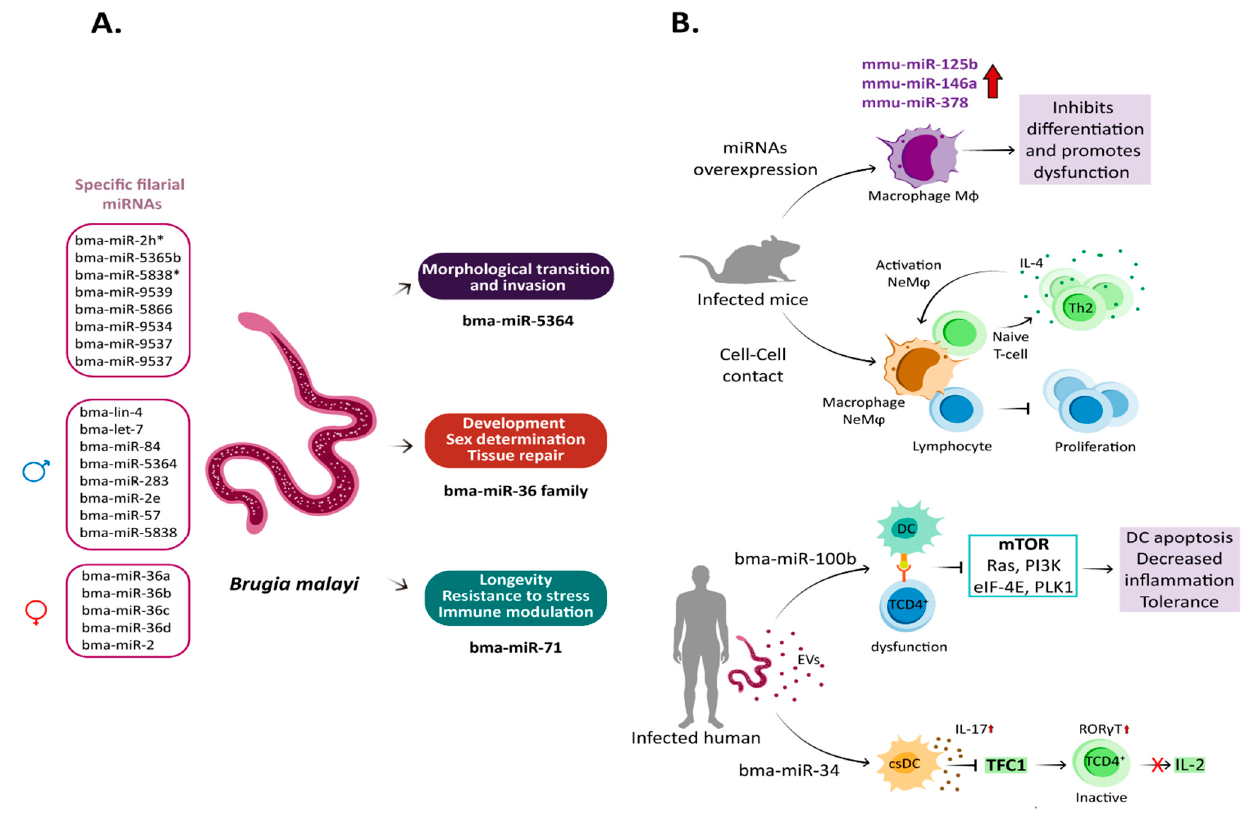
Figure 3. MicroRNAs during B. malayi infection. ( A ). MiRNAs identified in B. malayi . Specific miRNAs with gender-biased expression have been identified in B. malayi . Thus, bma-miR-5364, bma-miR-71, and the bma-miR-36 family regulate biological processes, including host immune modulation. ( B ). Alteration of host’s miRNAs during B. malayi infection. Infection by this parasite induces miRNA upregulation related to immune dysfunction. Alternatively, this parasite can induce NeM ϕ differentiation that can exert an anti-proliferative effect on lymphocytes, mediated by cell-to- cell contact. For its part, miRNA EVs derived from the parasite (bma-miR-100 and bma-miR-34) are internalized by functional DCs. In the cytoplasm, they modulate mTOR signaling pathways, cellular proliferation, differentiation, and apoptosis-related genes. Adobe Illustrator was used to elaborate the figure.